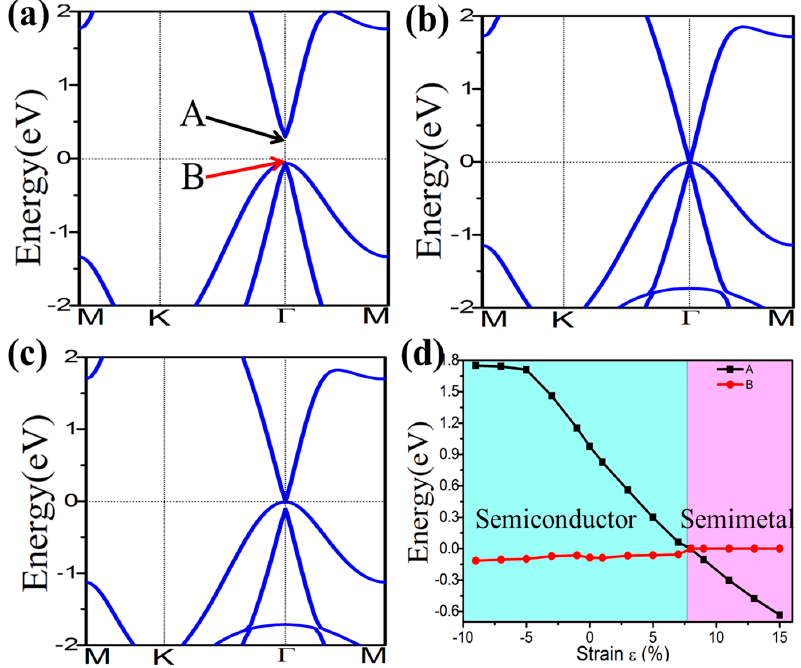
Figure 5. Electronic band structures of GeH under the strain of 0% ( a ); 8% ( b ); and 9% ( c ). Panel ( d ) plots the evolution of the energy level of states A and B under external strain. Nanomaterials 2018 , 7 , x FOR PEER REVIEW